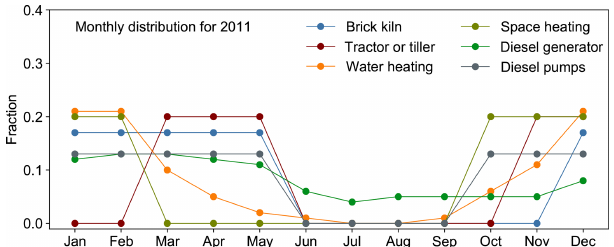
Figure 9. Temporal variability calculated in activity rates from Jan- uary to